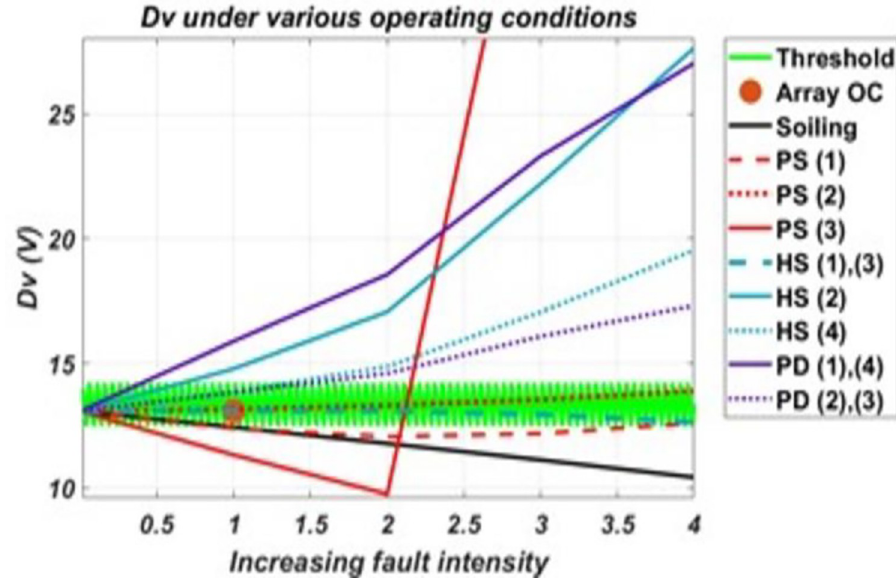
Fig 10. Response of Dv to various conditions and their varied intensity